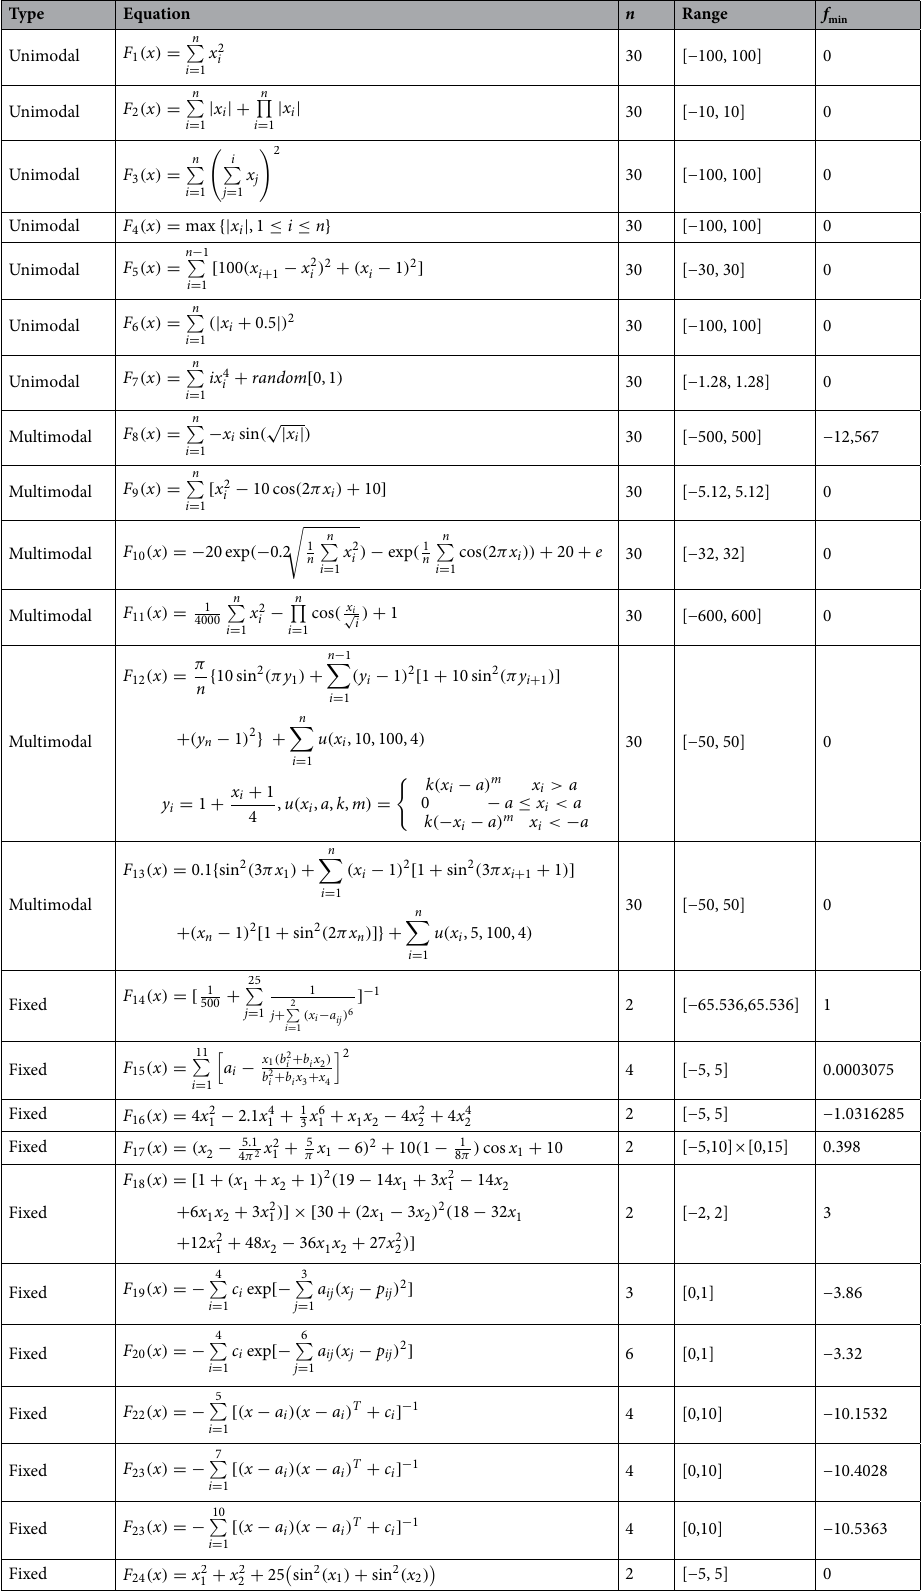
Table 1. Details of 24 classical benchmark